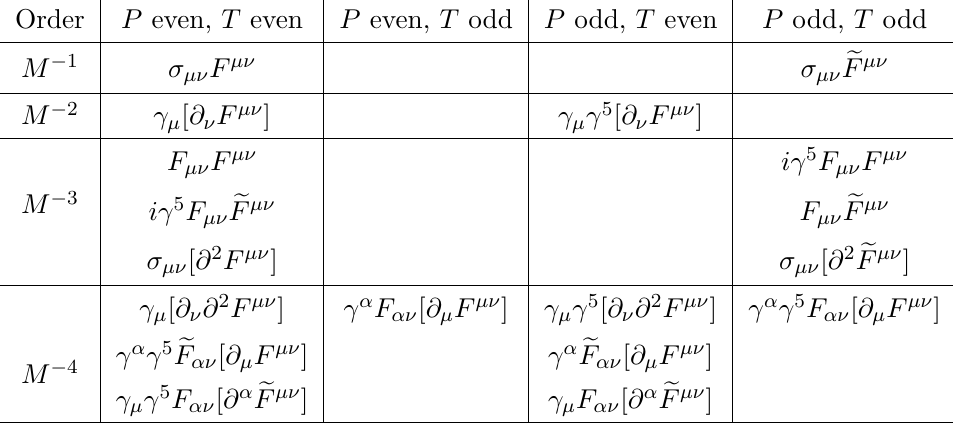
Table 2 . A basis of Hermitian, Lorentz-invariant, e(cid:11)ective operators in a relativistic theory of a single fermion, subject to an external U(1) gauge interaction, categorized by their charge under parity ( P ) and time reversal ( T ) transformations, up to and including dimension 8. The operators O listed in this table should be understood as sandwiched between two Dirac spinors, i.e., Q O Q . The square brackets indicate that the derivatives act only on the object within the square brackets. While this is explicitly a Lorentz-invariant theory, it can be rewritten as a reparameterization- invariant theory by making the replacements Q ! (cid:9) v and D (cid:22) ! D (cid:22) . See section 4 for de(cid:12)nitions and details.